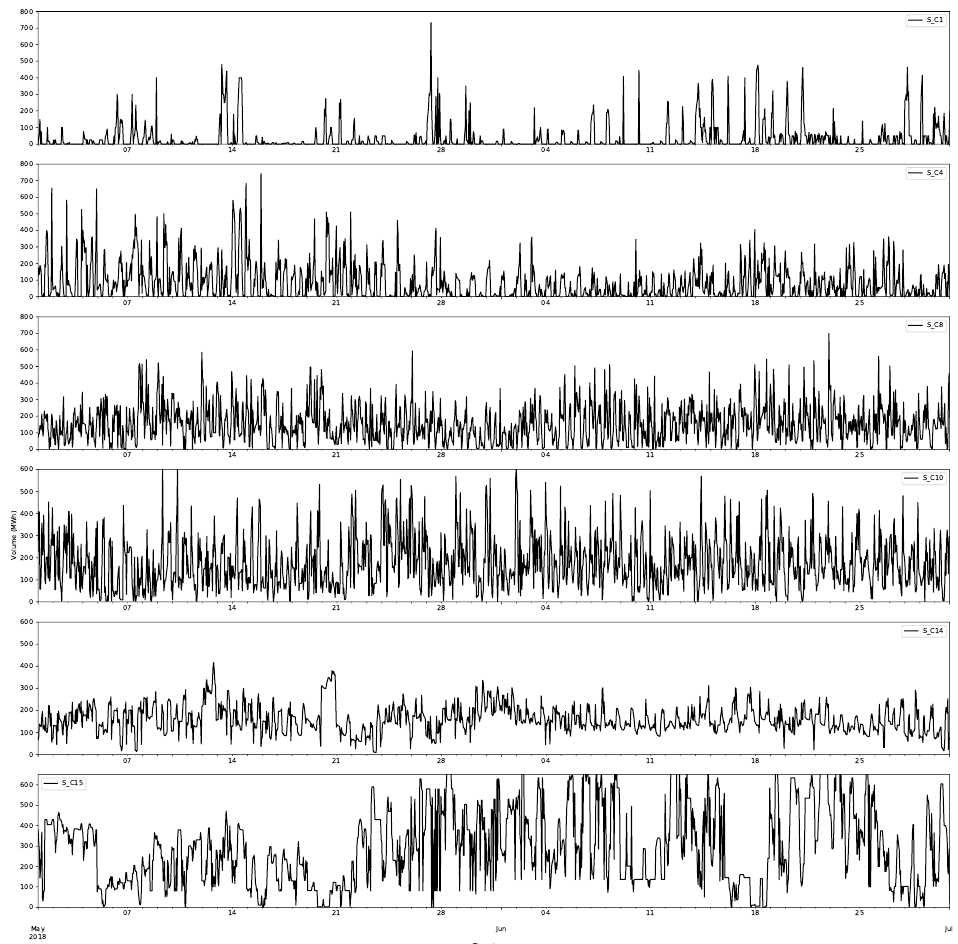
Figure 10. Selected classes for the supply volume time